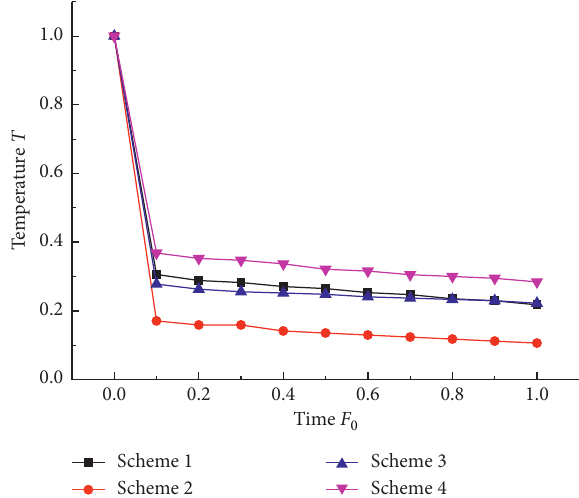
Figure 10: Variations of temperature T on the TIG layer wall at 0.9 R with time.